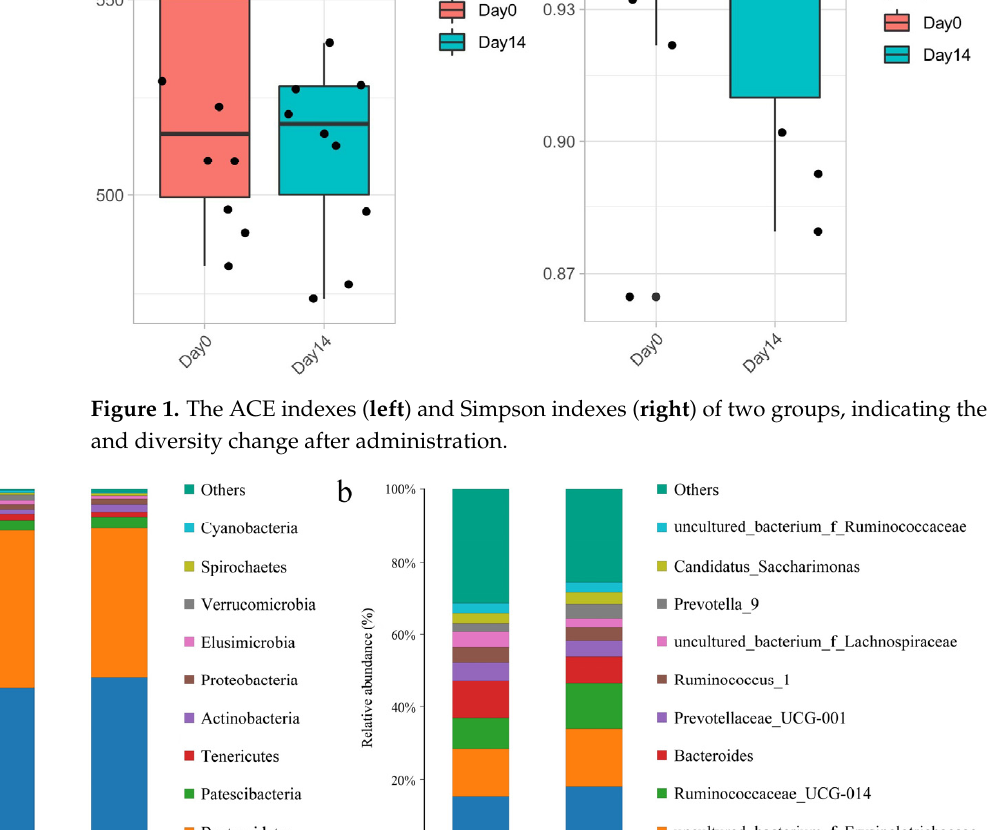
Figure 2. ( a ) The composition of fecal bacterial microbiota in day 0 and day 14 group at the phylum level. ( b ) The composition of fecal bacterial microbiota in day 0 and day 14 group at the genus level.